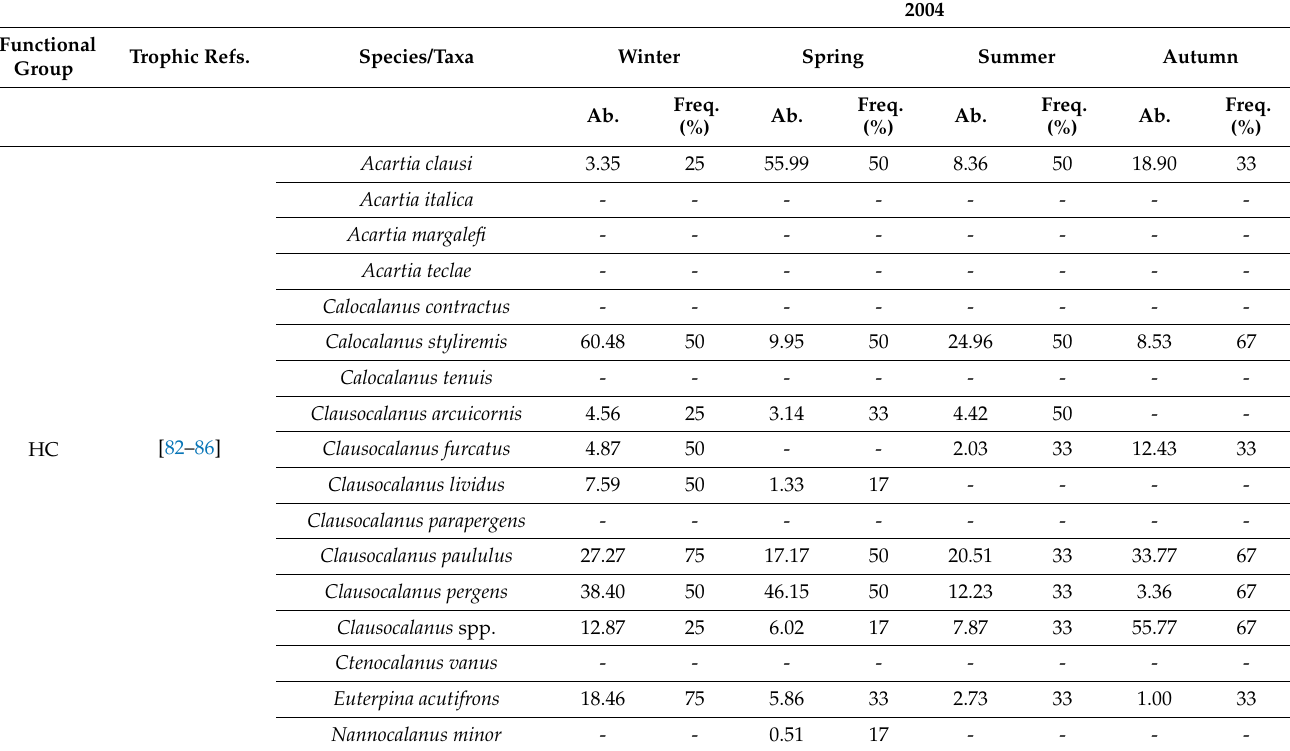
Table A4. Abundance and frequency of species in 2004